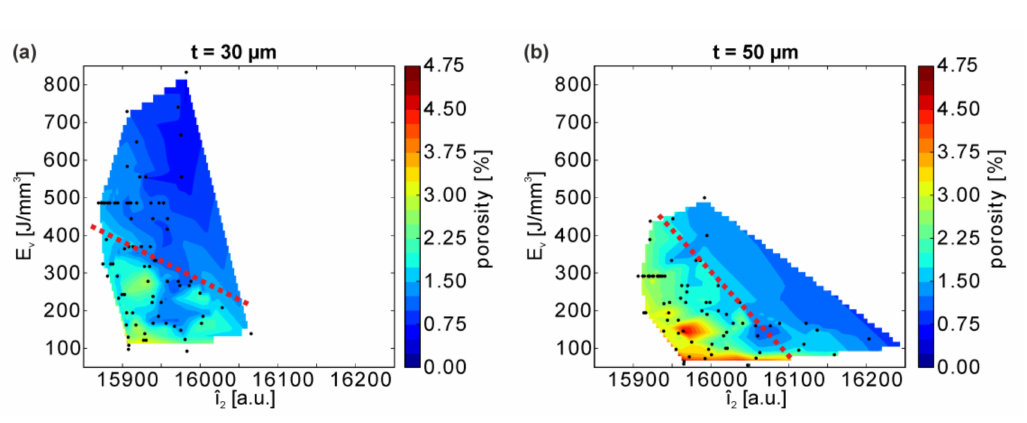
Figure 7. Porosity correlation with the volume energy density E v and the bulk mean intensity Î 2 for 2 di ff erent layer thicknesses. ( a ) t = 30 µ m and ( b ) t = 50 µ m. The black dots indicate measured data points and the regions in between are linearly